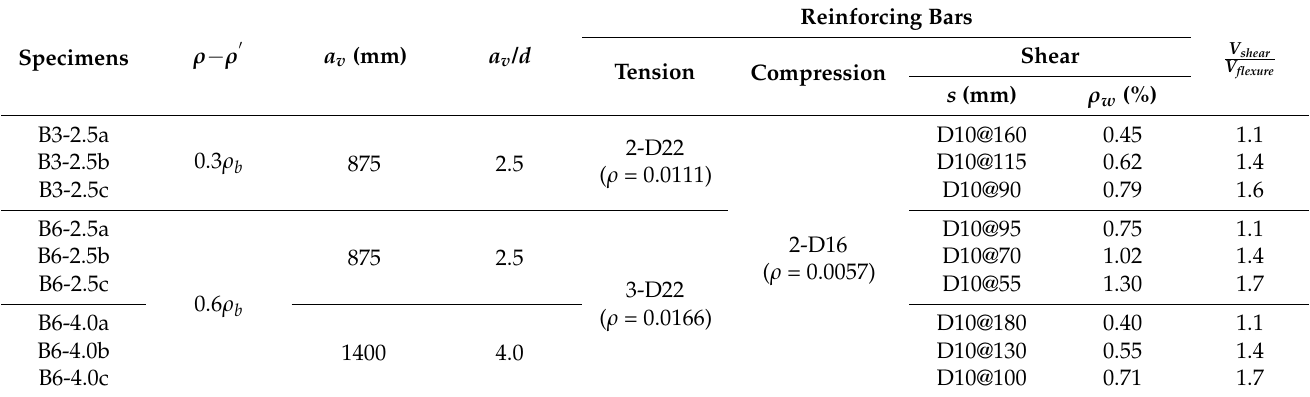
Table 2. Details of tested